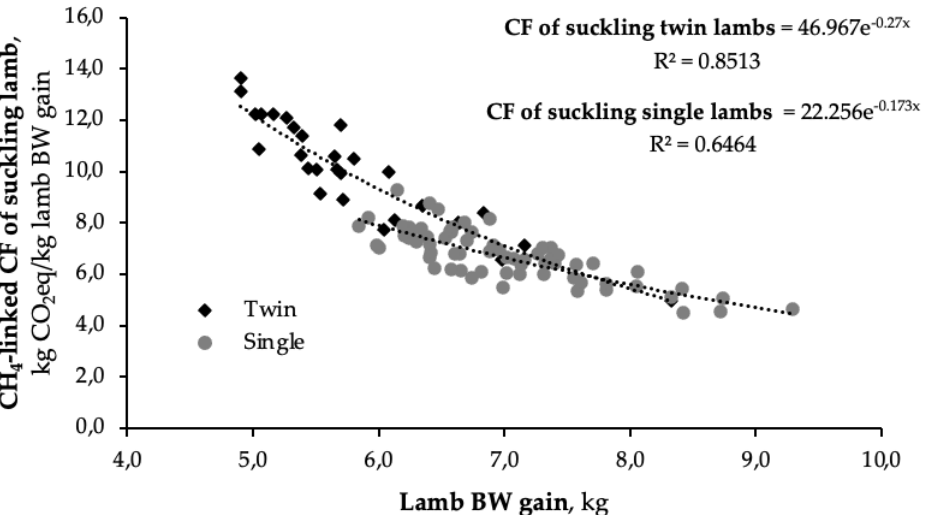
Figure 3. Allometric relation between CH4-linked carbon footprint (CF) of suckling lamb and body weight (BW) gain of twins and single-born lambs.